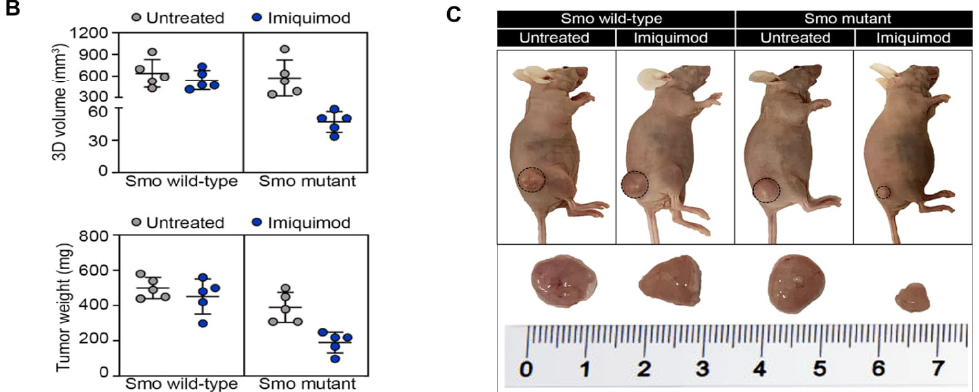
Figure 5. ( A ) Schematic representation of experimental strategy. Mice were injected subcutaneously in the right flank with MeWo cells expressing the SMO wild-type or mutant gene (600,000 cells/mouse), as described in Materials and Methods. After 3 weeks (average tumor size 300 mm3) mice were treated with IMQ (25 mg/kg, every other day, by i.p.) for 3 weeks; ( B ) 3D volume (mm3) and tumor weight (mg) of SMO wild-type and mutant-gene-amplified MeWo tumor xenografts, treated with vehicle or IMQ i.p. Data are means ± SD of five mice in each group; ( C ) Representative images of four group of mice enclosed into experimental plan: Group 1: SMO wild-type gene-amplified MeWo cell lines, devised into sub-group 1: vehicle control and sub-group 2: IMQ administrated by i.p.; Group 2: SMO mutant-gene-amplified MeWo cell lines, devised into sub-group 1: vehicle control and sub-group 2: IMQ administrated by i.p.